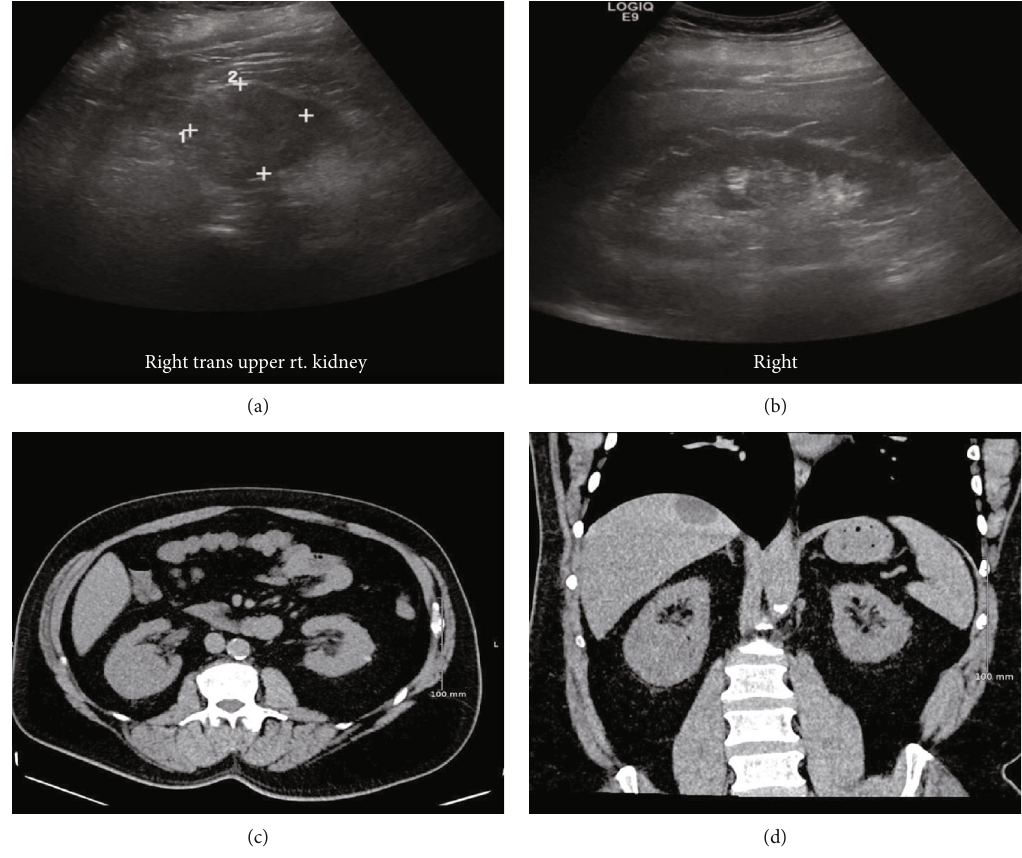
Figure 1: Ultrasound fi ndings: transaxial (a) and long axis (b) views show the right kidney containing a solid, heterogeneous isoechoic mass in the midpole. CT abdomen without IV contrasts coronal (c) and axial (d) views, respectively: a solid isodense mass of the mid to inferior pole of the right kidney protrudes into the renal sinus. There is minimal deformity of the renal contour by the lesion. An incidental cystic lesion of the liver is